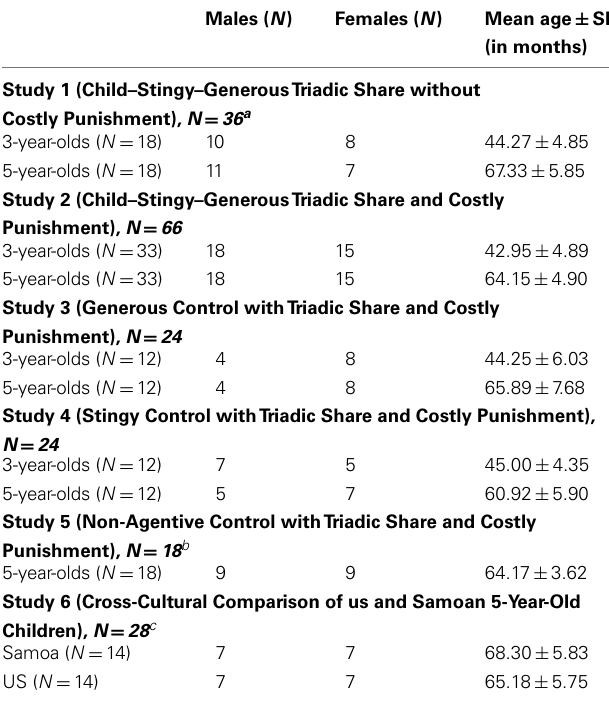
Table 1 | Descriptive statistics of participants in Studies